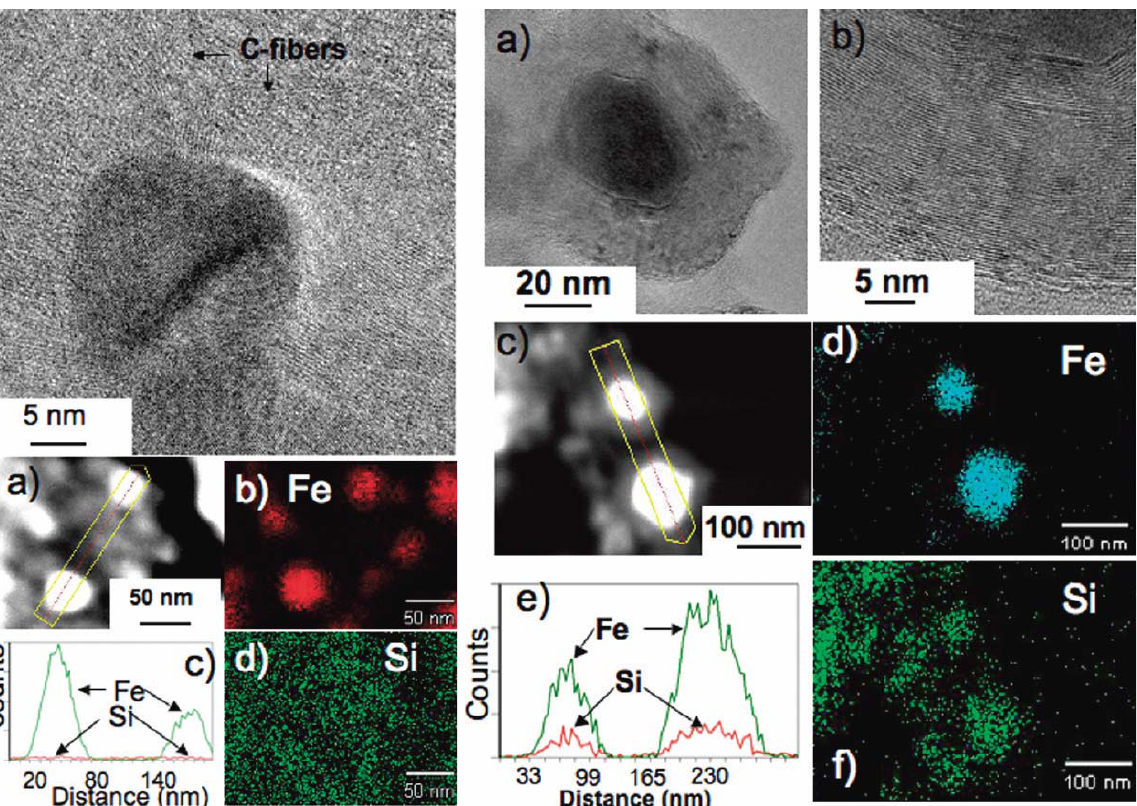
Figure 9. (Left) A HRTEM image showing bcc-Fe nanoparticles with protruding carbon fibers, (a) a HAADF image of two bcc-Fe particles encapsulated by carbon, (c) an EDS line scan across the two particles showing the presence of Fe, and (b) and (d) fine probe EDS maps for Fe and Si (present dispersed in the matrix), respectively. (Right) (a) A HRTEM image showing a Fe Si particle encapsulated by a carbon nanocapsule, (b) a high 5 3 magnification of a portion of the carbon nanocapsule showing the (0002) lattice fringes, (c) a HAADF image of two Fe Si particles encapsulated by carbon, (e) an EDS line scan 5 3 across the two particles showing the presence of Fe and Si, and (d) and (f) fine probe EDS maps for Fe and Si, respectively. Reproduced from [8] with permission from American Chemical